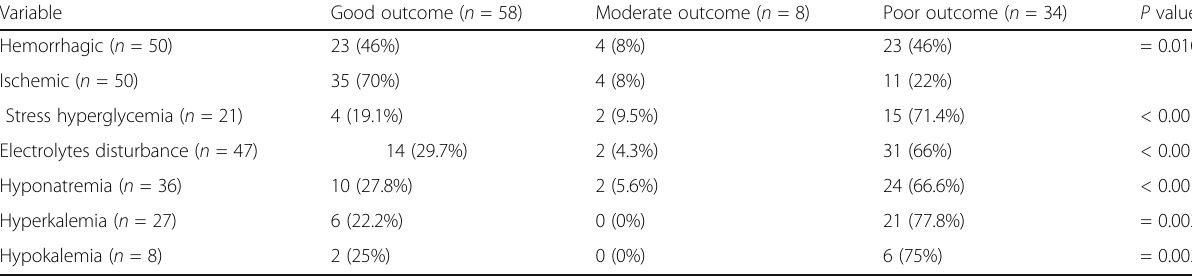
Table 3 Distribution of outcome of stroke patients according to the GCS after a week Variable Good outcome ( n = 58) Moderate outcome ( n = 8) Poor outcome ( n = 34) P value a Hemorrhagic ( n = 50) 23 (46%) Ischemic ( n =